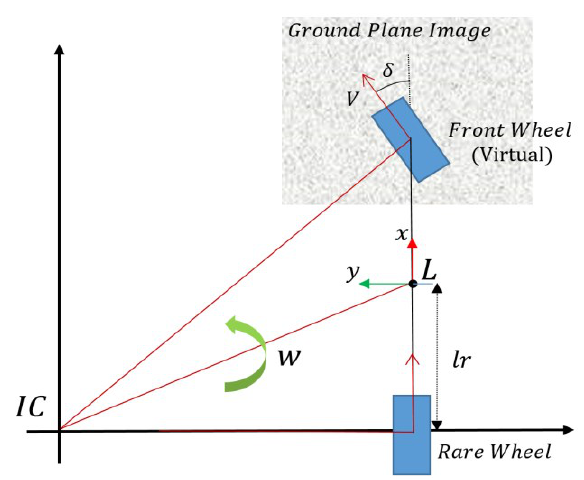
Figure 9 . Motion vector on the Ground Plane Image applying to the mobile robot’s motion model